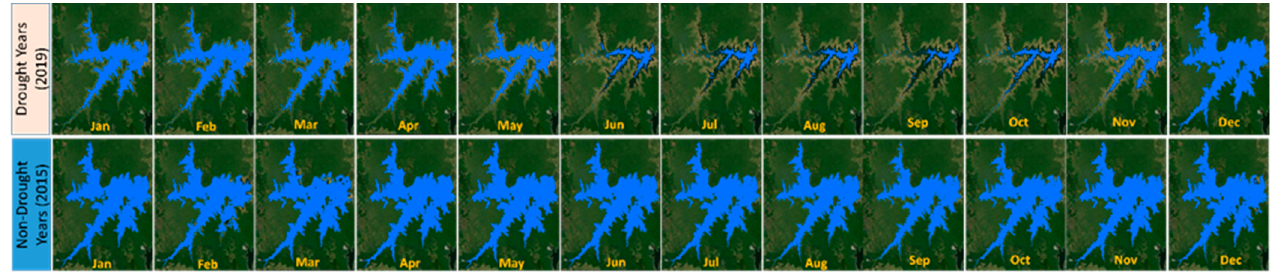
Figure 3. Surface water area dynamic of Tank D during drought (2019) and non-drought year